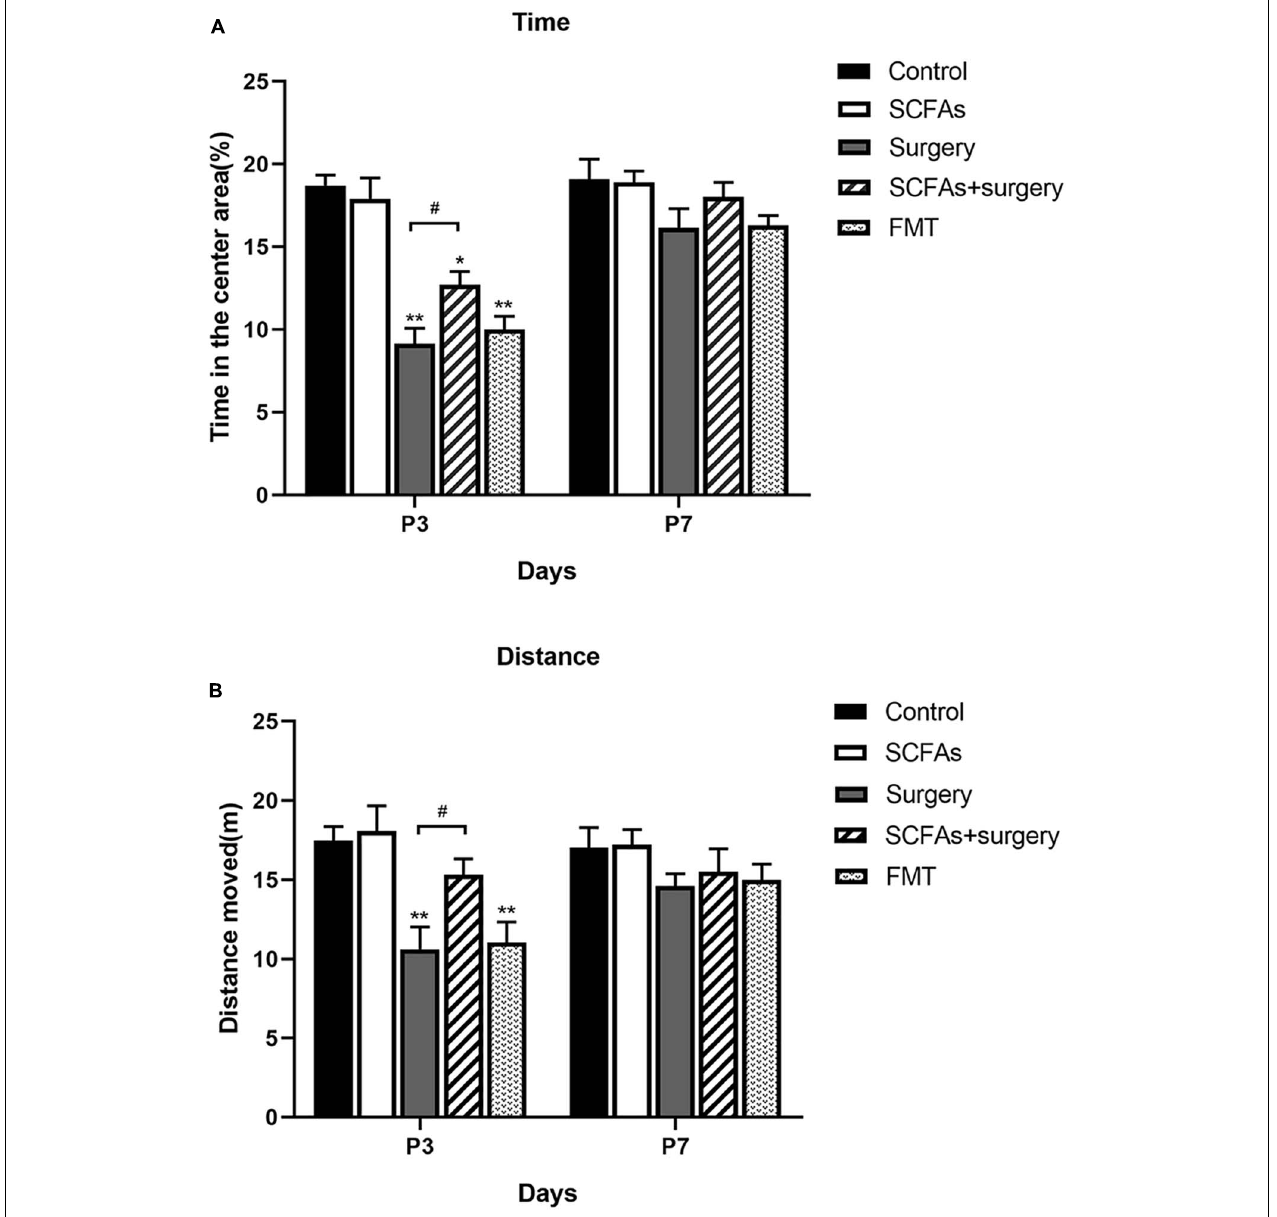
FIGURE 3 | Surgical trauma and anesthesia and fecal microbiota transplantation exacerbated neurobehavioral impairment on postoperative or post-transplantation day 3 in the open-field test. Treatment with SCFAs significantly improved behavioral performance on postoperative day 3. (A) The time spent in the center area. (B) Total distance moved in the center. The results are represented as mean ± SEM. * p < 0.05 vs. the day-matched control group, ** p < 0.001 vs. the day-matched control group, # p < 0.05 vs. the day-matched surgery group. P3 and P7: postoperative or post-transplantation days 3 and 7,